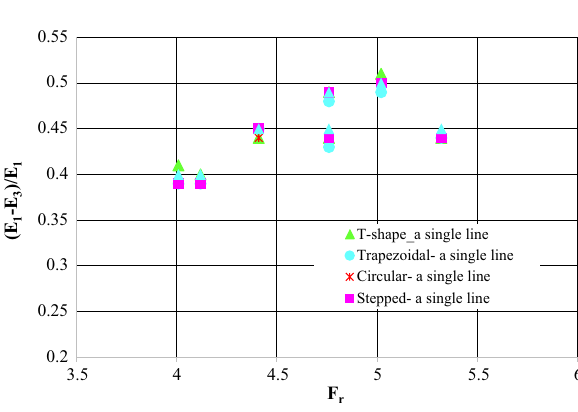
Fig. 14 Comparison of energy-dissipating ratios of two-row